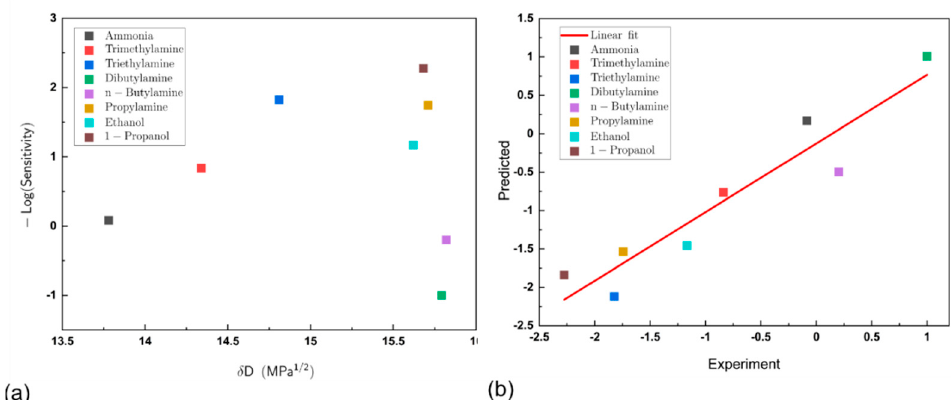
Figure 8. ( a ) Quantitative structure–activity model (QSAR) plot of log (sensitivity) versus the dispersion force ( δ D) for each analyte tested. No coherent trend can be seen; ( b ) good correlation is seen between the experimentally derived sensitivities for a series of amines with the predicted values from the model based on the Antoine constant C and the heat of vaporization at boiling point (Equation (9)).